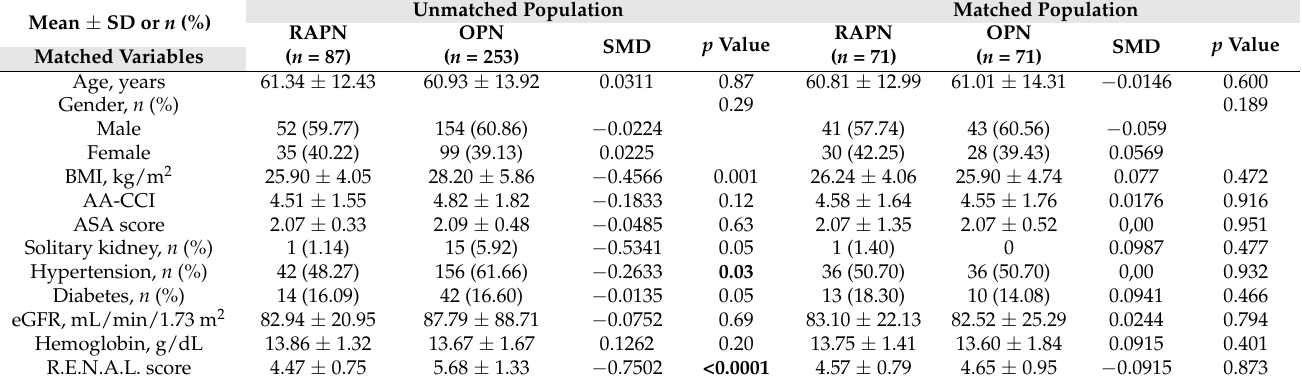
Figure 1. Study flowchart. Table 1. Comparison of baseline characteristics between groups in the unmatched and matched populations.